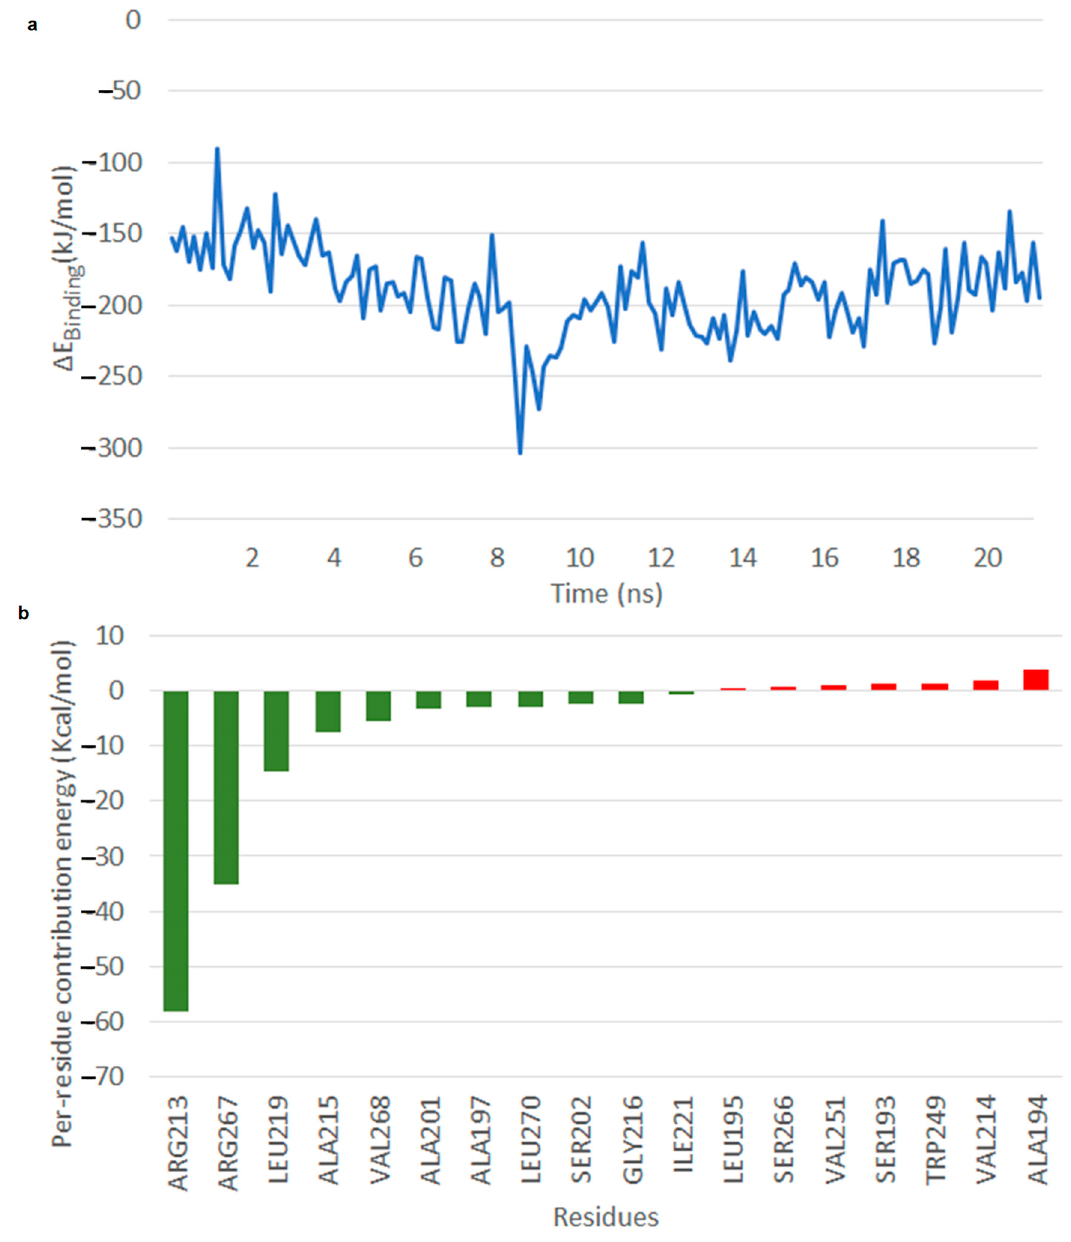
Figure 8. Interaction of TE with IS 2. ( a ) Free energy of binding of the TE–IS 2 interaction. ( b ) Per residue energy contribution.